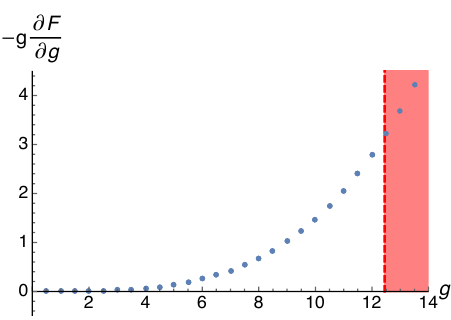
Figure 9 . Derivative of the free energy at d = 3 and a = 1 . The red area corresponds to g > g c , where nothing seems to happen, but in fact there is no λ giving such values of g